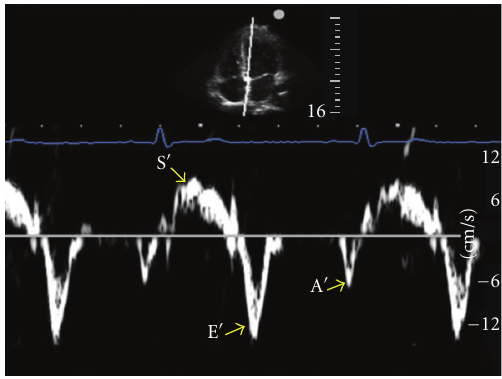
Figure 1: Spectral tissue Doppler tracing for the apical 4-chamber transthoracic window, showing the cursor position on the septal basal segment. The transducer is placed at the apex of the heart and angled towards the